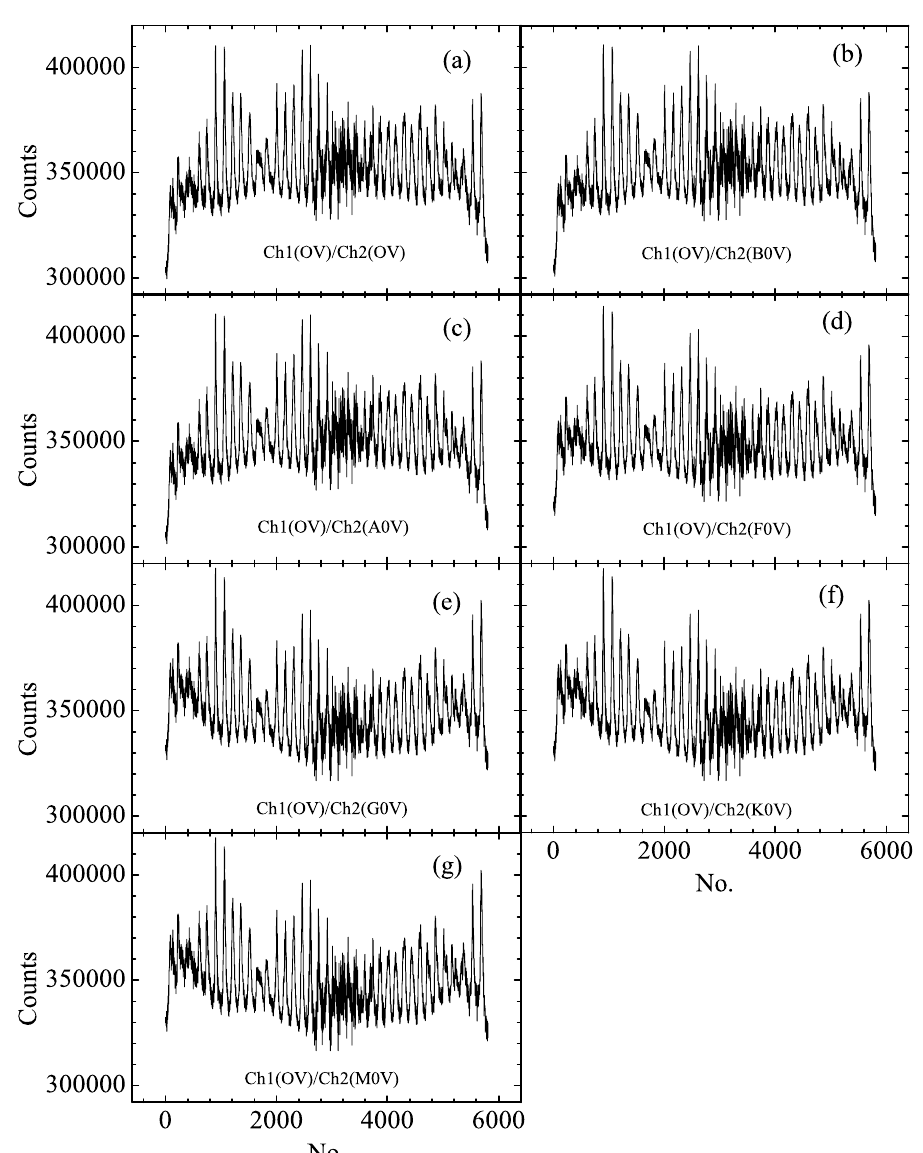
Fig. 14. Determination of spectral type of the comparison star using the new extinction correction method for real observations (May 28, 2002, McDonald Observatory, XCov19), when the light curve of the program star is divided by the light curve of the comparison star, assuming different spectral types for the comparison